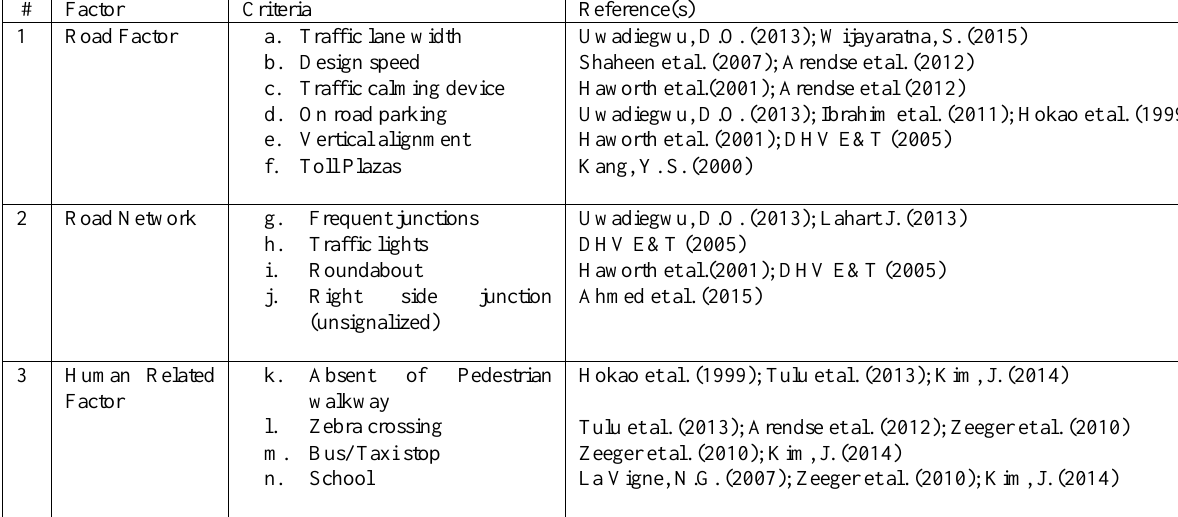
Table 1. List of research factor and